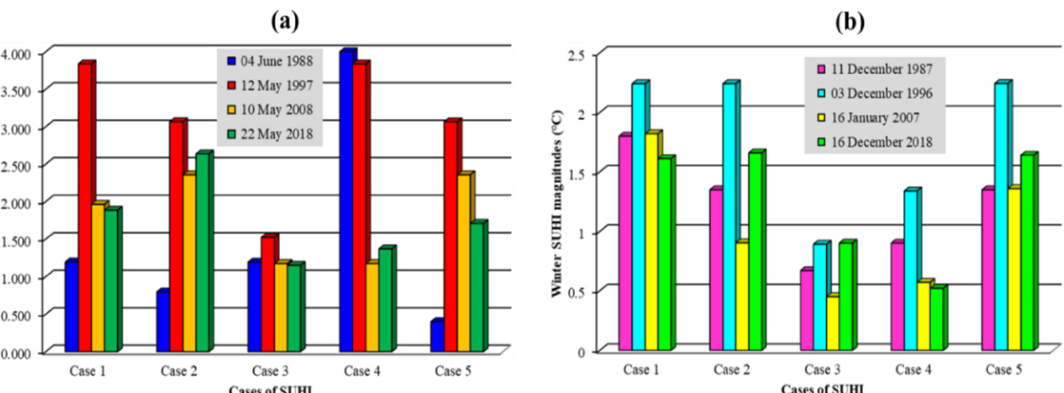
Figure 17. Seasonal SUHI dynamics at five case point locations in Prayagraj city (1987–2018) for all time points: ( a ) summer and ( b ) winter. Table 7. Seasonal SUHI magnitude based on rural/suburban point locations in Prayagraj city.